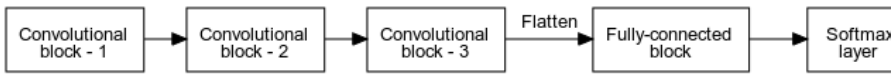
Figure 7. CNN architecture—NUS I dataset.